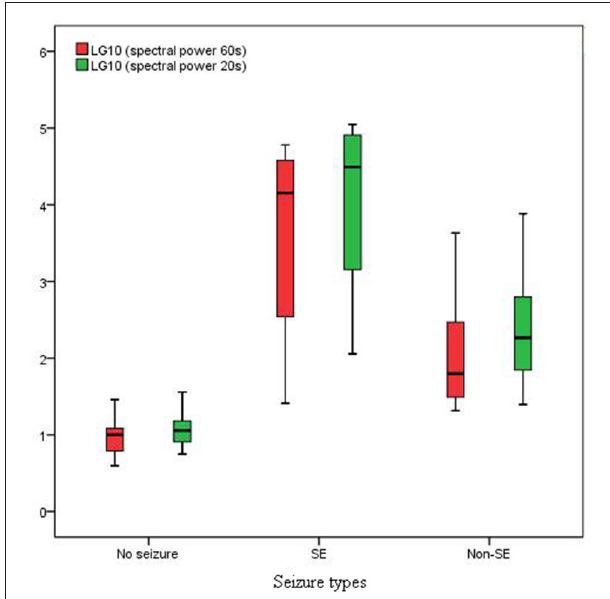
FIGURE 4 | Spectral power in SE group was much higher than that in non-SE and no seizure groups ( P < 0.01).